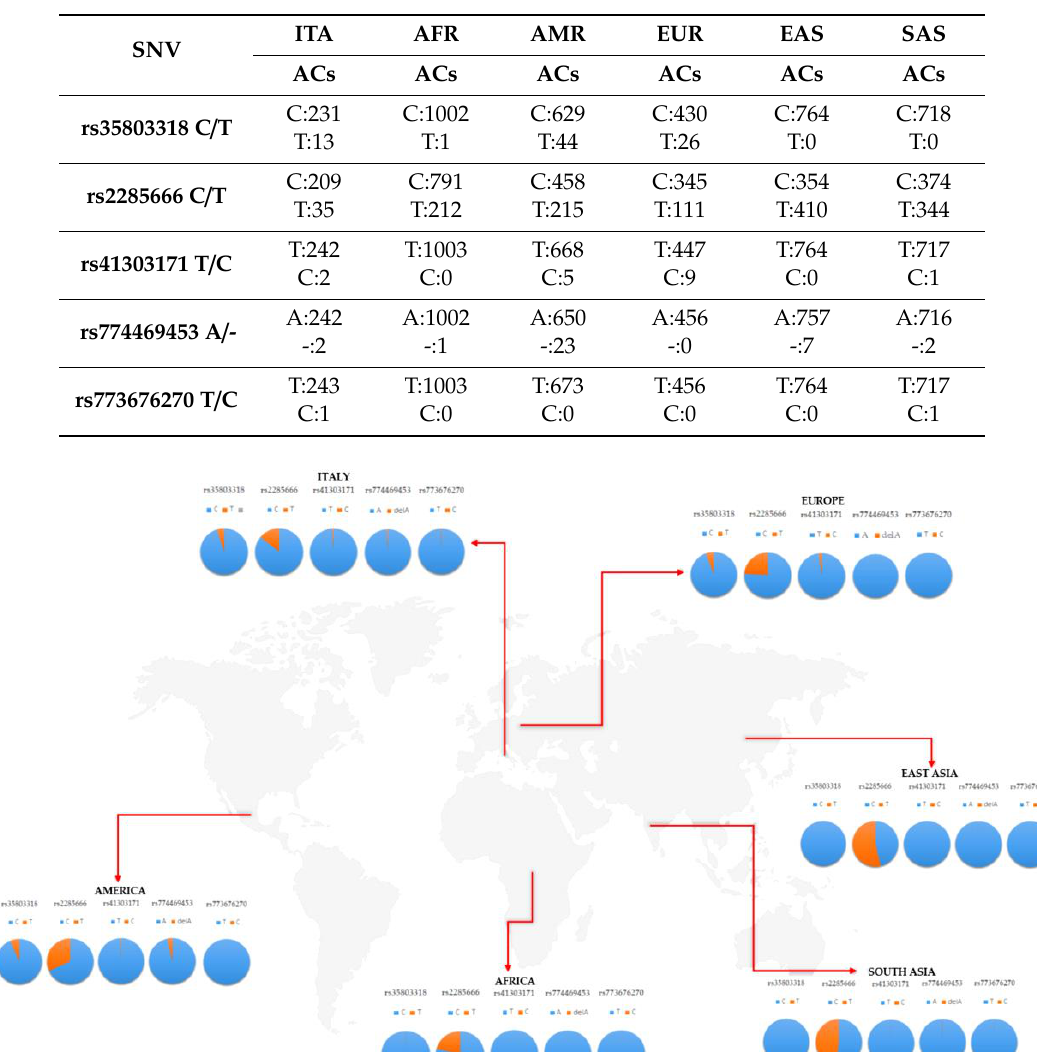
Table 1. Comparison of ACE2 allelic variants between the Italian and worldwide populations. Allele counts of the variants of interest for each population are shown. ITA: 168 Italians subjects; AFR: 661 African subjects from 1000 Genomes; Americans: 446 subjects, composed of 99 CEU (Utah residents with Northern and Western European ancestry) subjects and 347 AMR (Latino Americans) subjects,